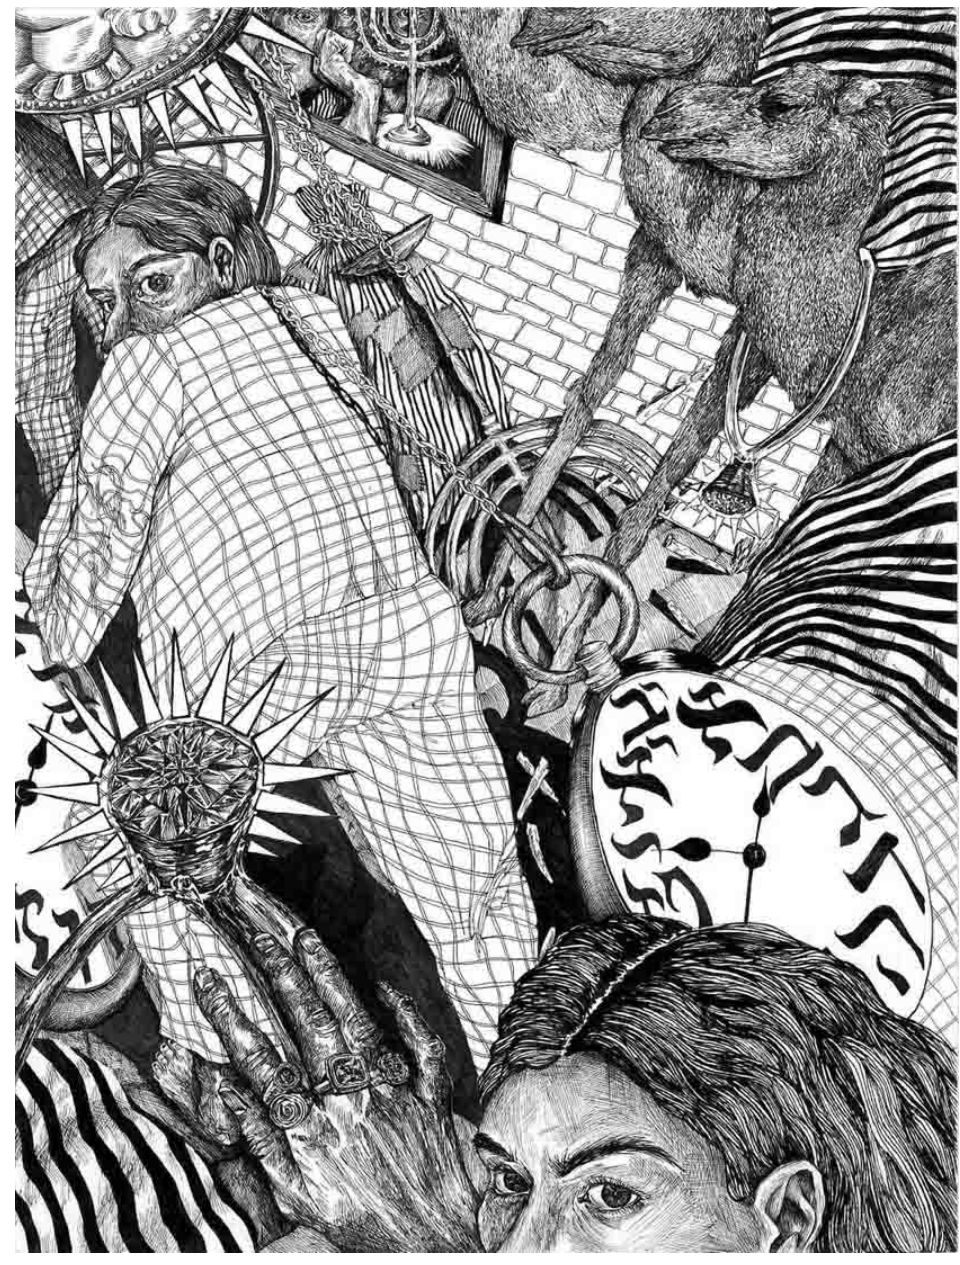
Rosabel Rosalind Kurth-Sofer, Exodus III , 2018. Pen and ink on paper. 9x11